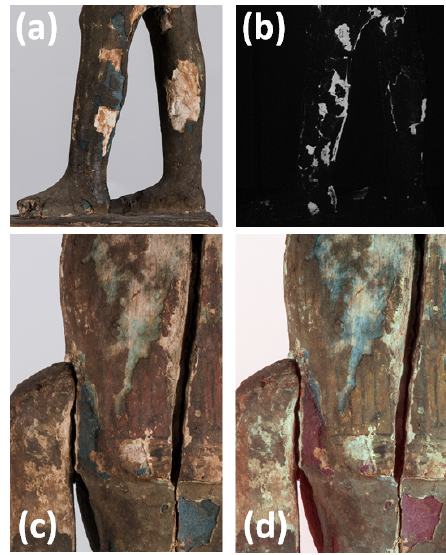
Figure 6. Photographs of part of legs ( a ) and of back/wig; ( c ) VIL image of the same part of the legs ( b ) in which the luminescent areas are made of Egyptian blue; ( d ) IRFC image of the back/wig in which green pigment (turquoise color) is more evident.